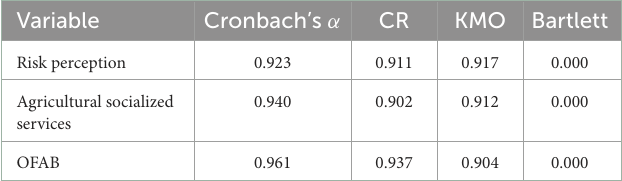
TABLE 3 Reliability and validity test